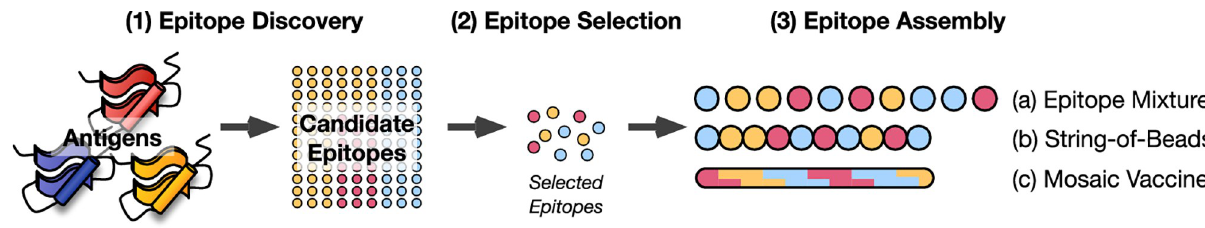
Fig 1. Epitope-based vaccine pipeline. An epitope-based vaccine pipeline is comprised of three major steps: (1) epitope discovery, (2) selection, and (3) assembly. Different types of vaccine design exist: (3a) epitope mixture, (3b) string-of-beads, and (3c)